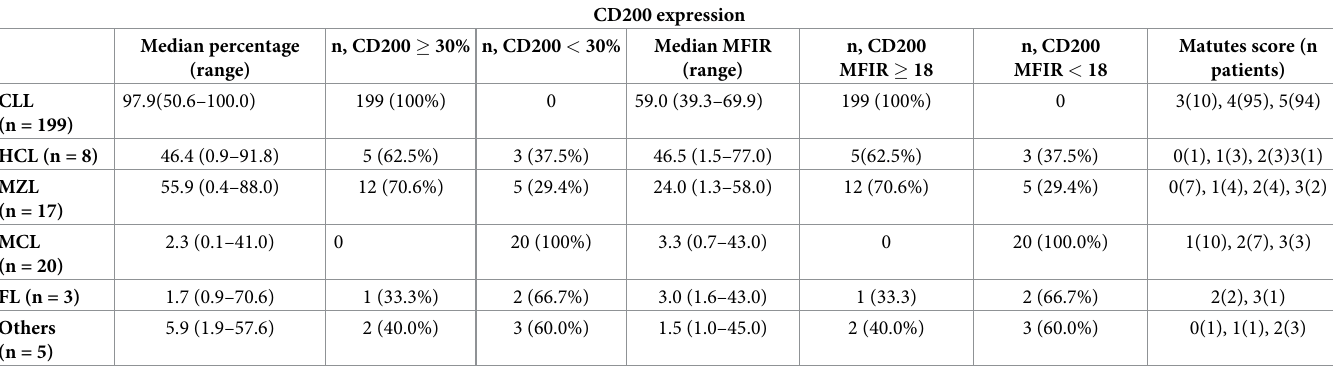
Table 2. CD200 expression in B-cell chronic lymphoproliferative disorders.